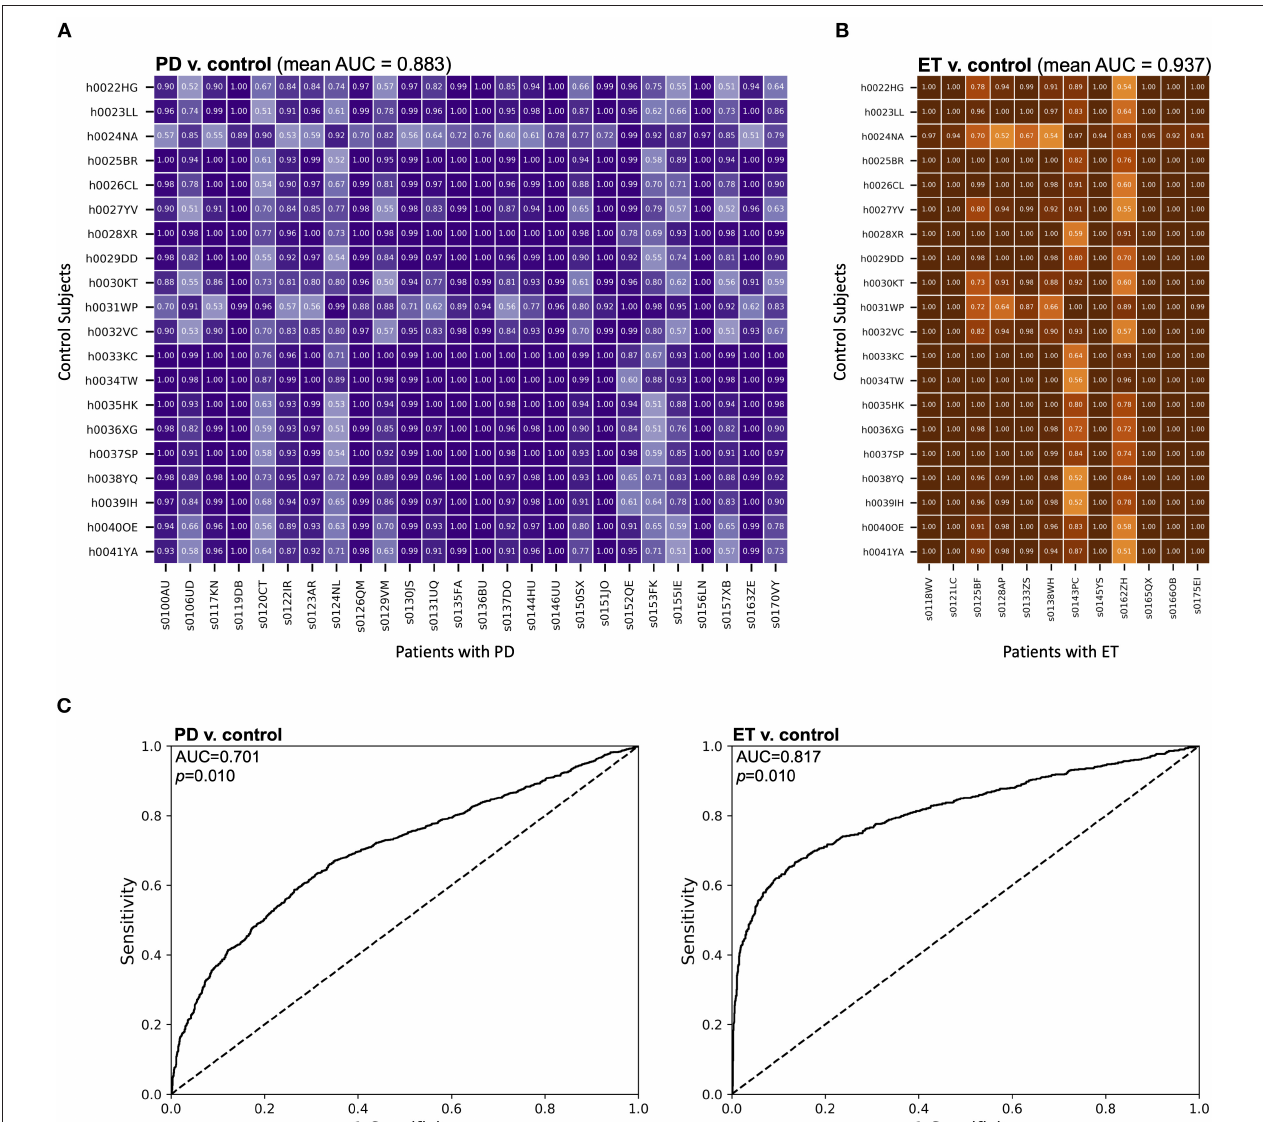
FIGURE 3 | MES effectively discriminated between movement disorder patients and control subjects. (A,B) The distributions of MES over a session were compared between individual control subjects and (A) patients with PD or (B) patients with ET. Here, unique SVM models were generated for each comparison and the resulting MES for each control subject-patient combination were calculated based on these models. These MES distributions were then compared using a ROC analysis. The AUC for each comparison was then calculated. AUCs for each pair-wise comparison are shown. (C) ROC curves were generated from compiled MES distributions from each subject group. All MES were derived from an SVM comparison of individual subjects within a group with a random sampling of pooled control data. The AUCs were then calculated to quantify the discriminatory ability of each